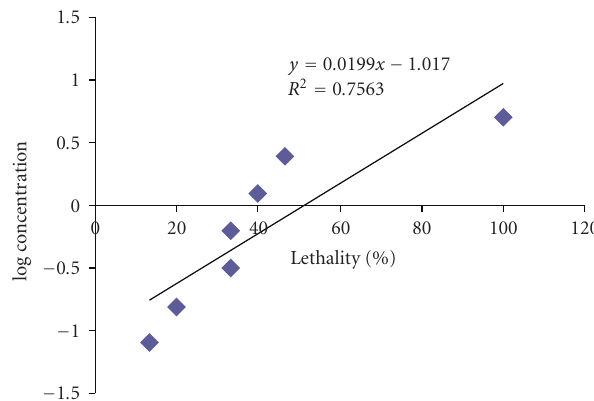
Figure 1: Toxic e ff ects of the P. microphylla hexane extract of method I after 24 hours using brine shrimp lethality